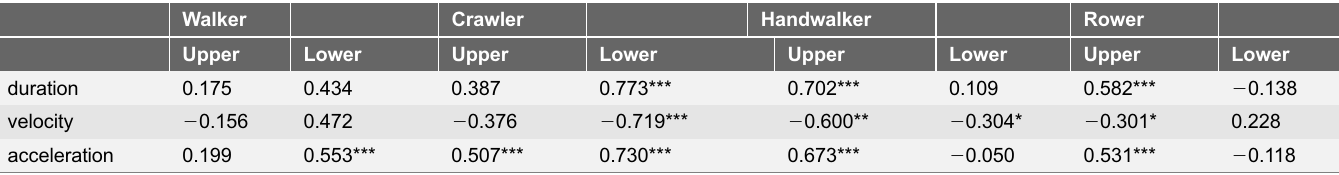
Table 1. Pearson correlation between sensitivity on the one hand and the asymmetry between forward and backward motion for duration, velocity, and acceleration for the upper and lower body in the different actions on the other hand.